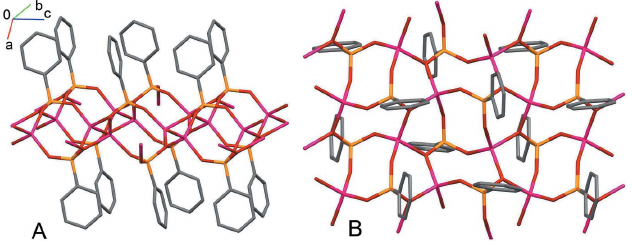
Figure 2 Side (A) and top (B) view of I highlighting its layered structure. H atoms have been omitted for clarity.